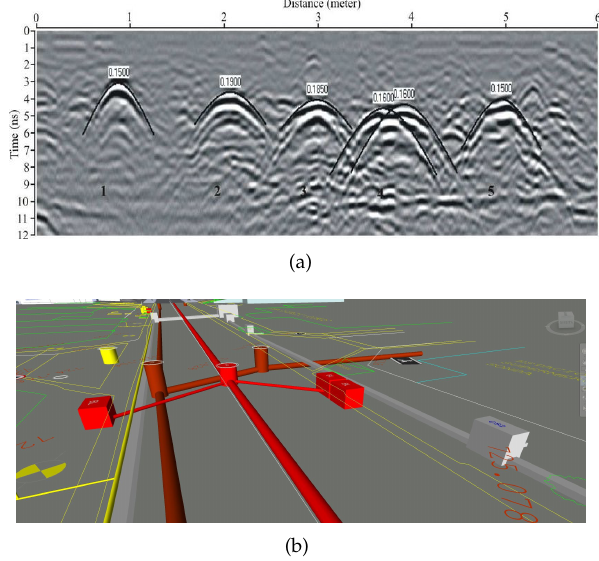
Figure 13. Example of the final result of the GPR case. ( a ) raw image from GPR; ( b ) processed image from GPR.